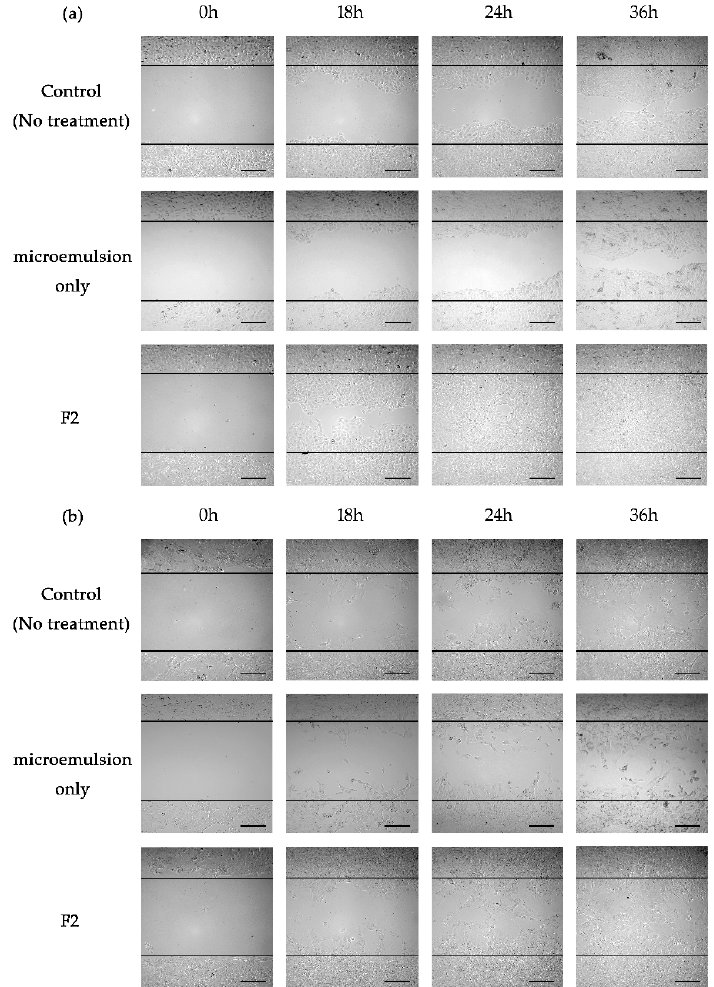
Figure 5. In vitro scratch assay for skin regeneration ( a ) HaCaT keratinocyte cell line; ( b ) NIH3T3 fibroblast cells were scratched and treated with or without F2 containing CoQ10 (1 mg / mL). Each image was taken at 0, 18, 24, and 36 h after the treatment. (Scale bar, 200 μm)